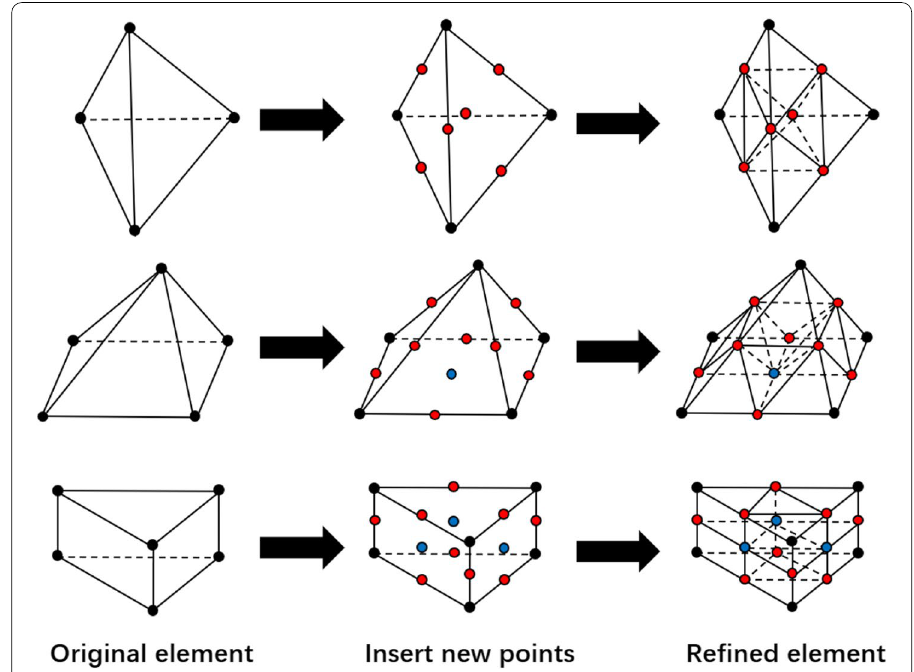
Fig. 9 Refinement templates of 3D